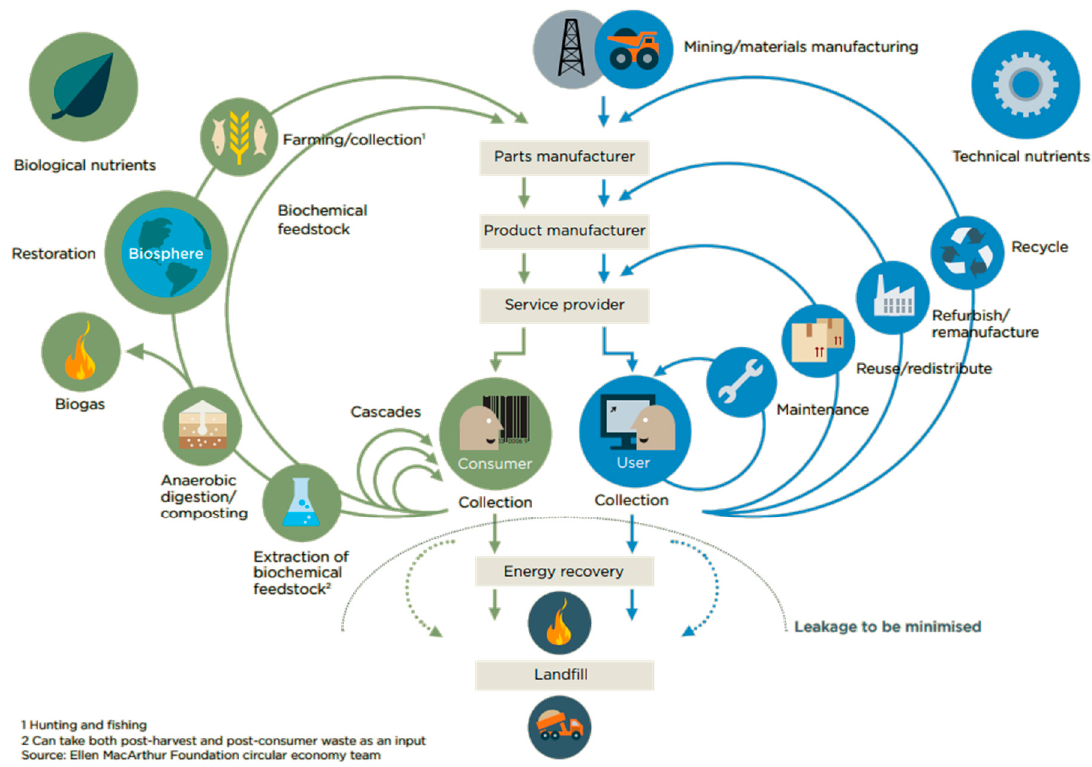
Figure 1. Cycles in Circular Economy. Source: Ellen MacArthur Foundation [4].